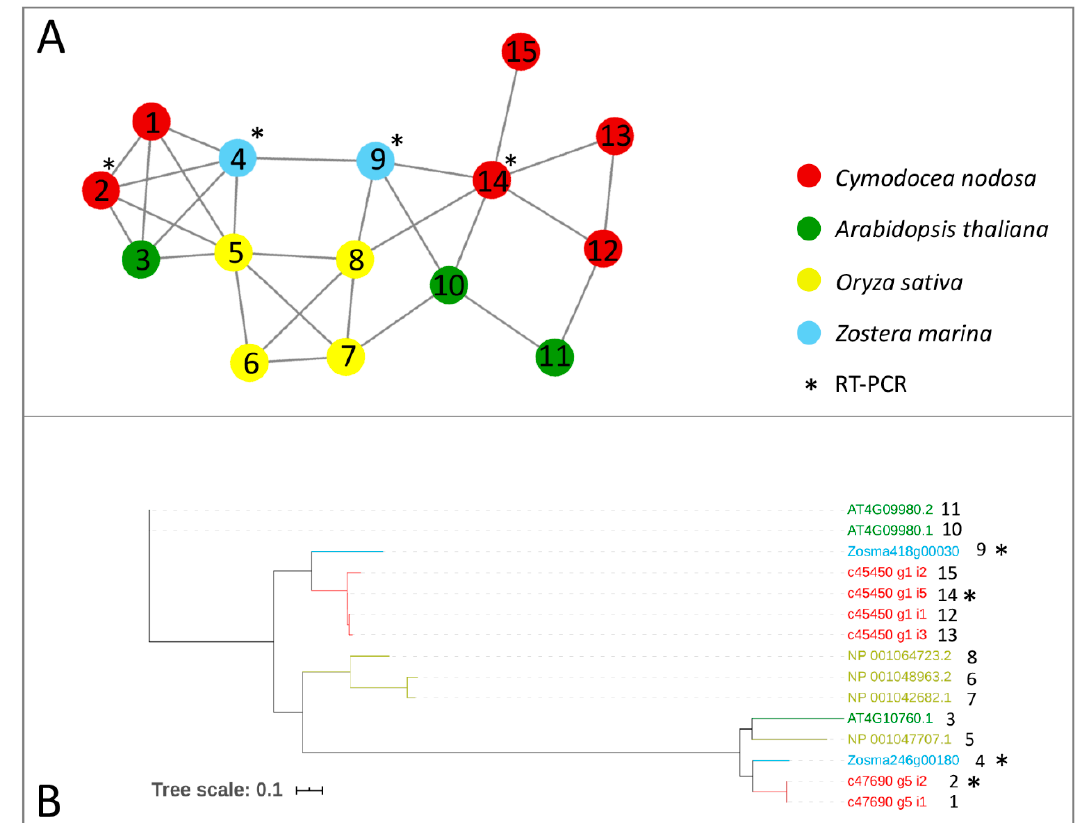
Figure 1. Orthologs / paralogs networks of writers: ( A ) MTA and MTB writers (NET_3623). Circles represent proteins per species, according to the legend. Grey lines represent homology relationships. Transcript sequences analysed by RT-qPCR are marked with an asterisk; ( B ) Phylogenetic tree of MTA and MTB writers, constructed using an Approximately Maximum-Likelihood algorithm.